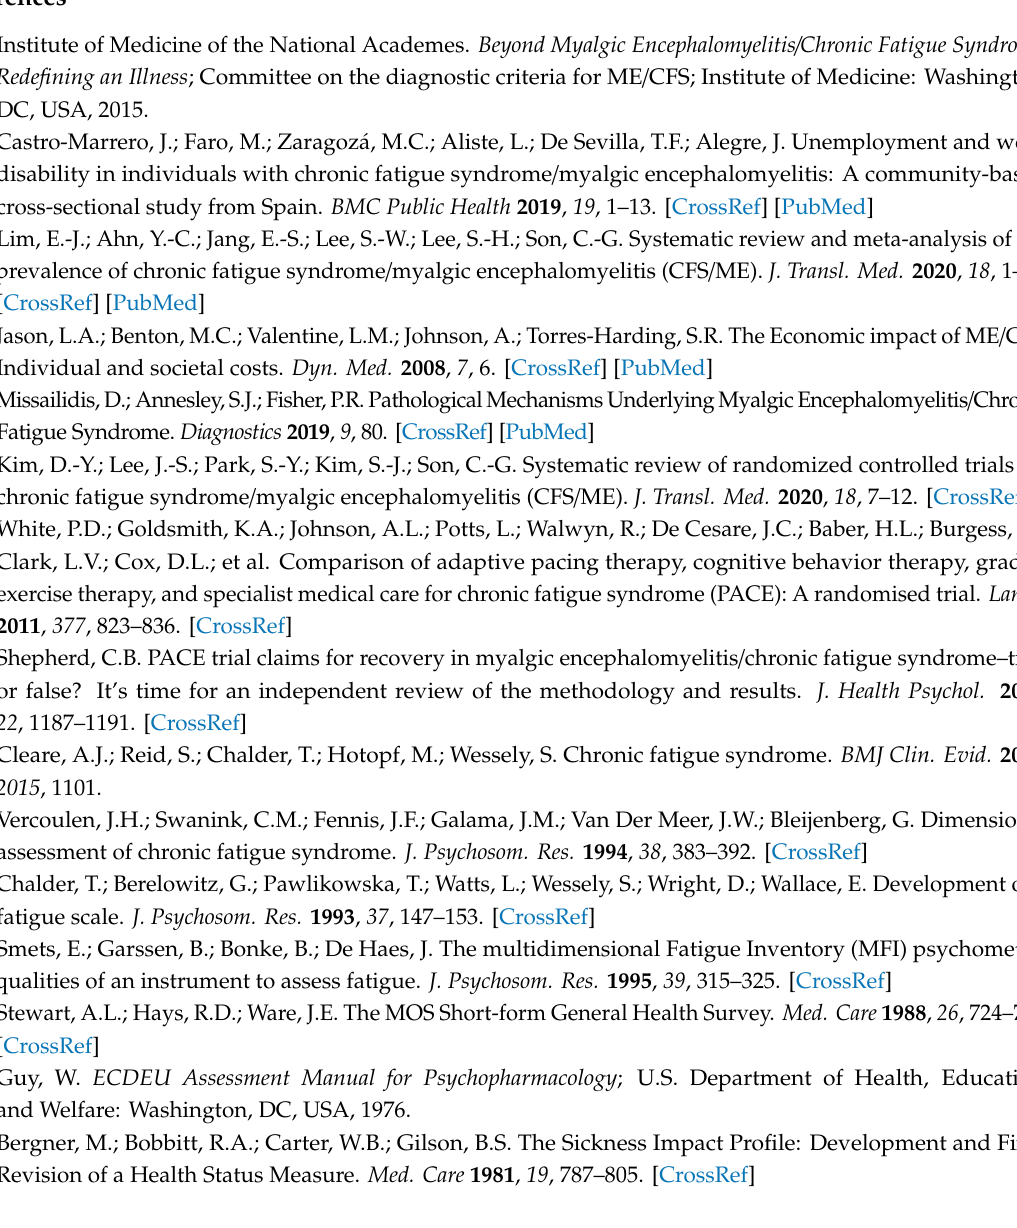
Table S1: Summary of RCTs included in this review, Table S2: General characteristics of self-reported survey measurements used in